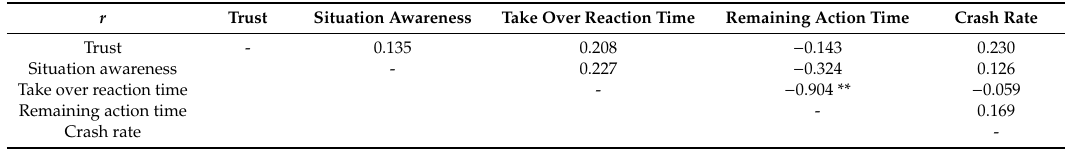
Table 3. Pearson correlation between variables.